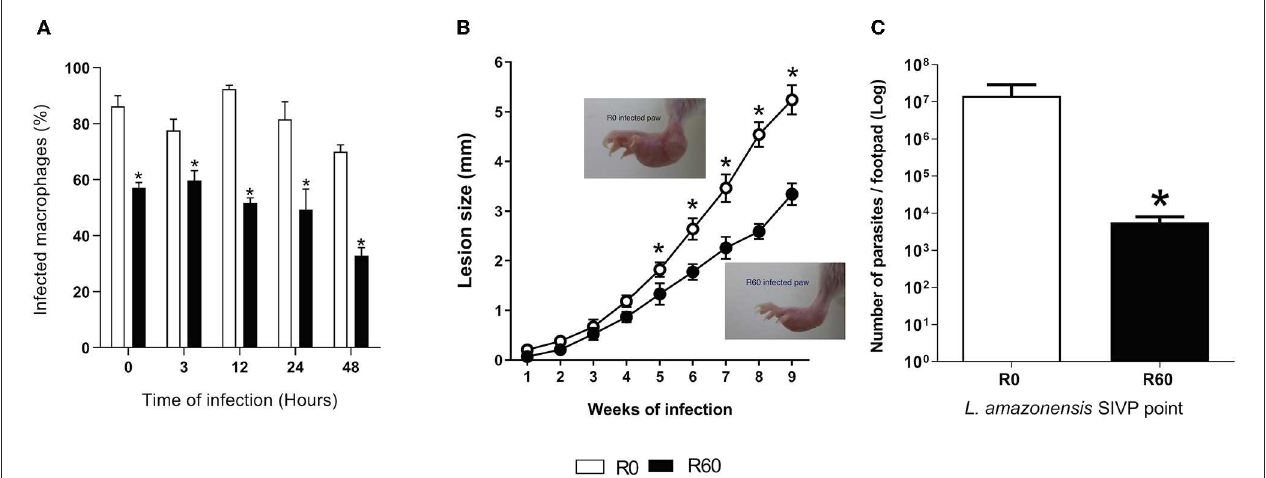
FIGURE 1 | In vitro BMM 8 infection, lesion size development and tissue parasitism in footpads of BALB/c infected with R0 and R60 strains. (A) Percentage of infected bone marrow-derived macrophages. BALB/c bone marrow-derived macrophages (2 × 10 5 cells/ml) were infected with R0 or R60 grown for 7 days, at late stationary phase (5 parasites/macrophage). The cells were fixed and stained with Giemsa after 3h of exposure (defined as 0h time) and after 3, 12, 24, and 48h post infection. The percentage (%) of infected macrophages was obtained by manual counting using an optical microscope. 300 cells at three different wells were evaluated from two different assays. (B) Evaluation of footpad lesion size from BALB/c mice infected with 1 × 10 6 L. amazonensis R0 or R60 stationary phase promastigotes. Lesion size was weekly measured with a caliper, and represent the size of infected paw minus the size of the non-infected one. Each point represents an average of lesion size from six infected mice plus the standard error (95% confidence interval). In detail, photographs of R0 and R60 infected paws at 8 weeks post-infection. (C) Limiting dilution assay, performed at 2nd week post-infection. Infected BALB/c footpads were homogenized in a glass homogenizer with M199 medium. The obtained pellet was resuspended in 500 µ l of M199 medium and submitted to serial dilution (in duplicate) 1:10 in 96-well micro plates at final volume of 200 µ L and incubated at 26 ◦ C for 15 days. The last dilution at which viable parasites was observed was considered the final titer. Results were expressed as negative logarithm of the parasites title. Bars represent mean values of three biological replicates from four infected BALB/c footpads plus standard deviation of the mean. * indicates p ≤ 0.05 (Two-way ANOVA with Bonferroni post-test).